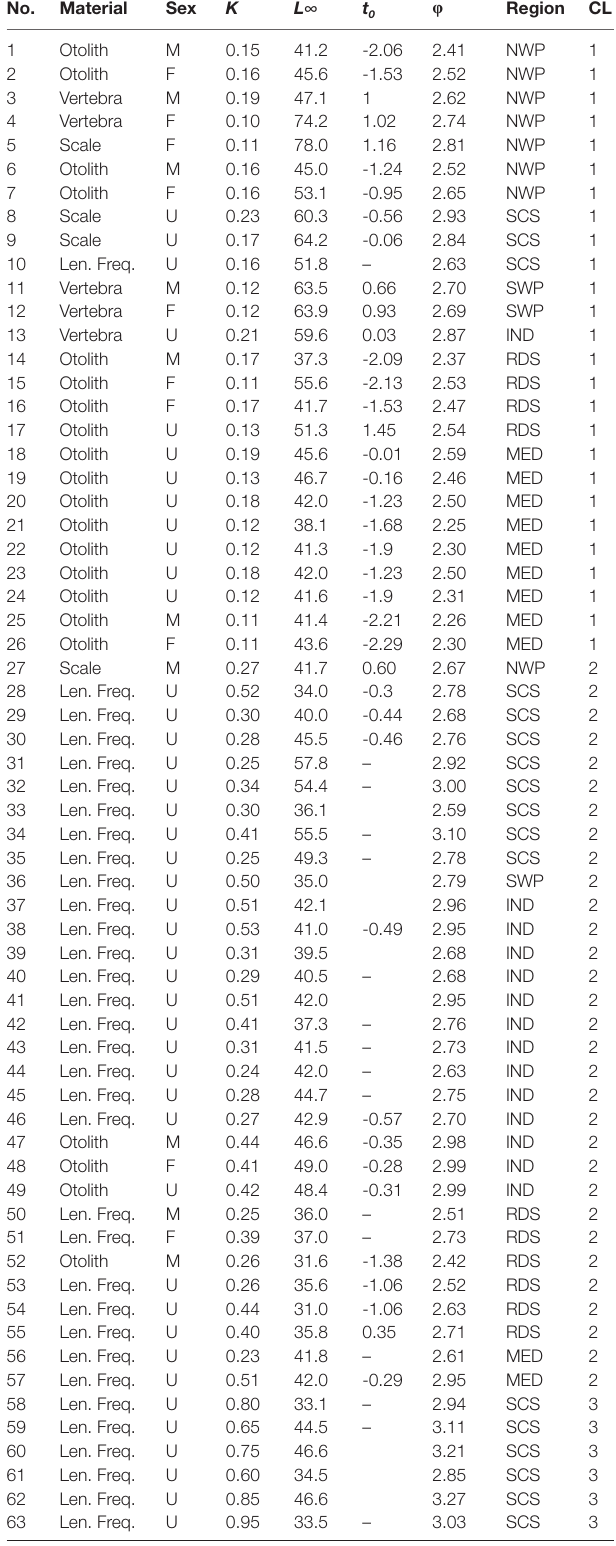
TABLE 1 | Global estimates of von Bertalanffy growth parameters of brushtooth lizardfish from the literature. No.